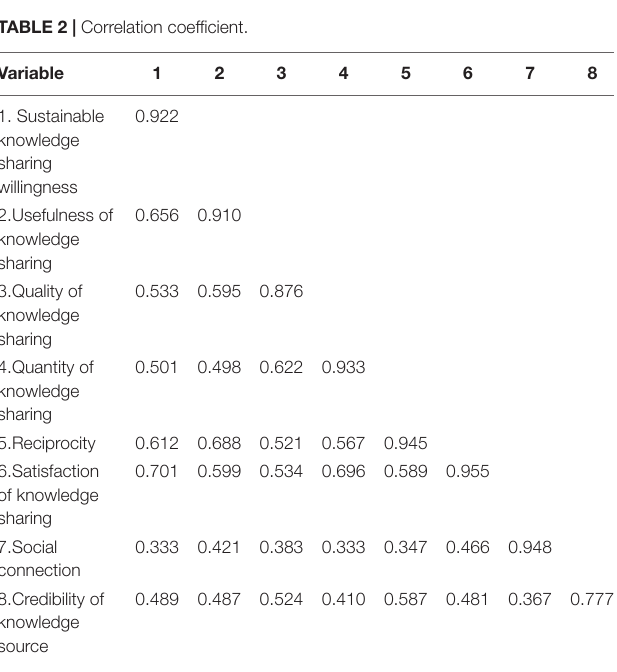
TABLE 2 | Correlation